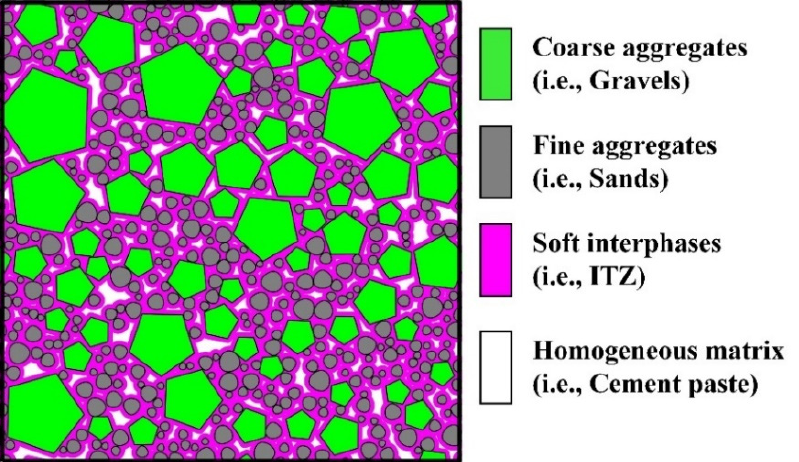
Figure 5. The meso-scale model of polyphase concrete composed of pentagonal coarse aggregates, oval fine aggregates, ITZ and homogeneous matrix ( D eq = Fuller 1.0–4.5 mm for ovals, D eq = Fuller 5–20 mm for regular polygons).